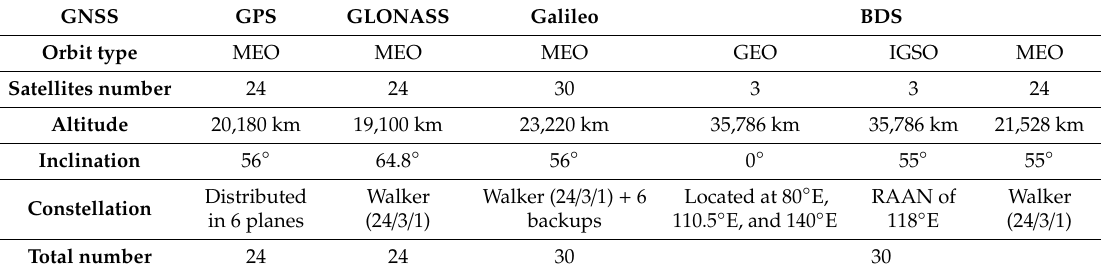
Table 1. Nominal constellation configuration of GPS, GLONASS, Galileo, and